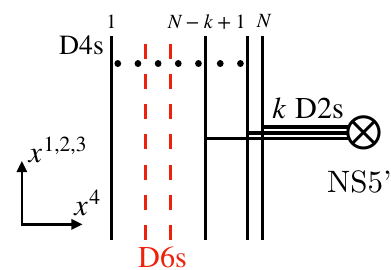
Figure 2. The k D2-branes stretched between an NS5’-brane on the right and the stack of D4- branes realize an ’t Hooft operator with the charge corresponding to the anti-symmetric represen- tation ∧ k V of U( N ) . An NS5’-brane on the left would give an operator corresponding to ∧ k V . The locations of the D6-branes in the x 6 -direction do not affect the